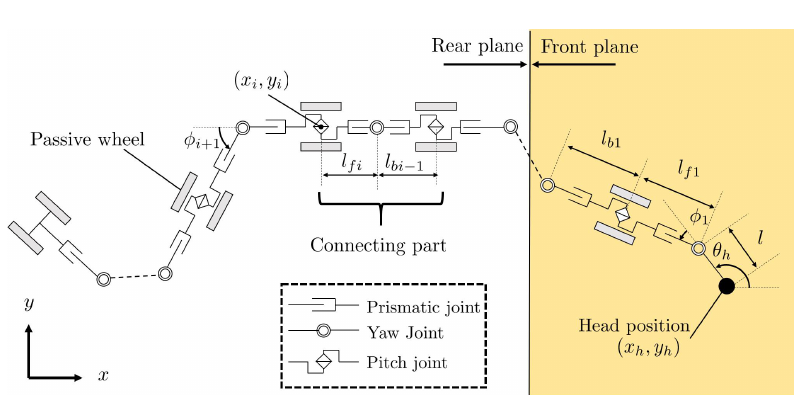
Figure 2. A projection model on the xy